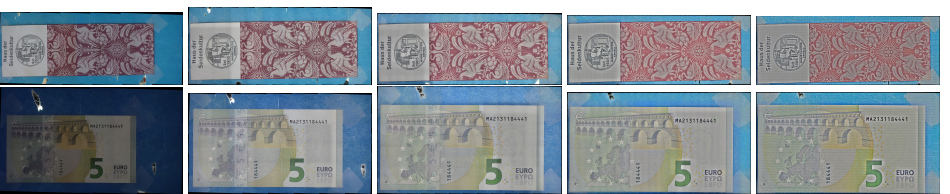
Figure 14. Fabrics.